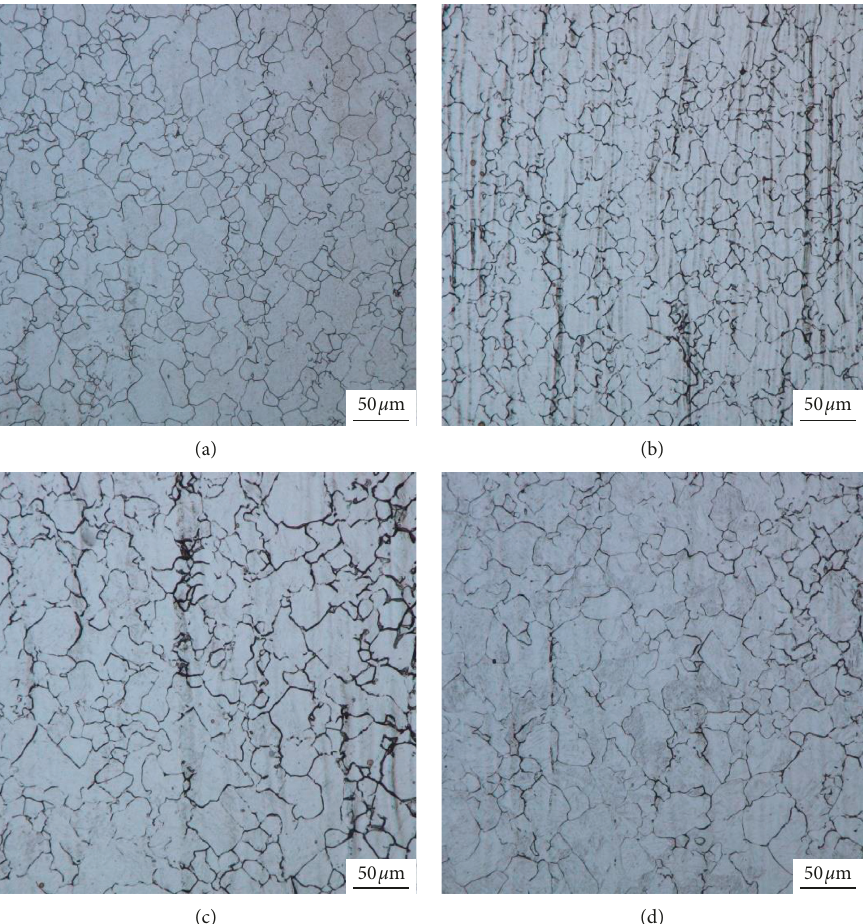
1 and a tensile −